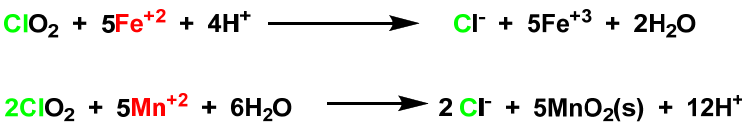
Figure 24. ClO 2 oxidizes Fe(II) and Mn(II) via rapid one ‐ electron transfer.